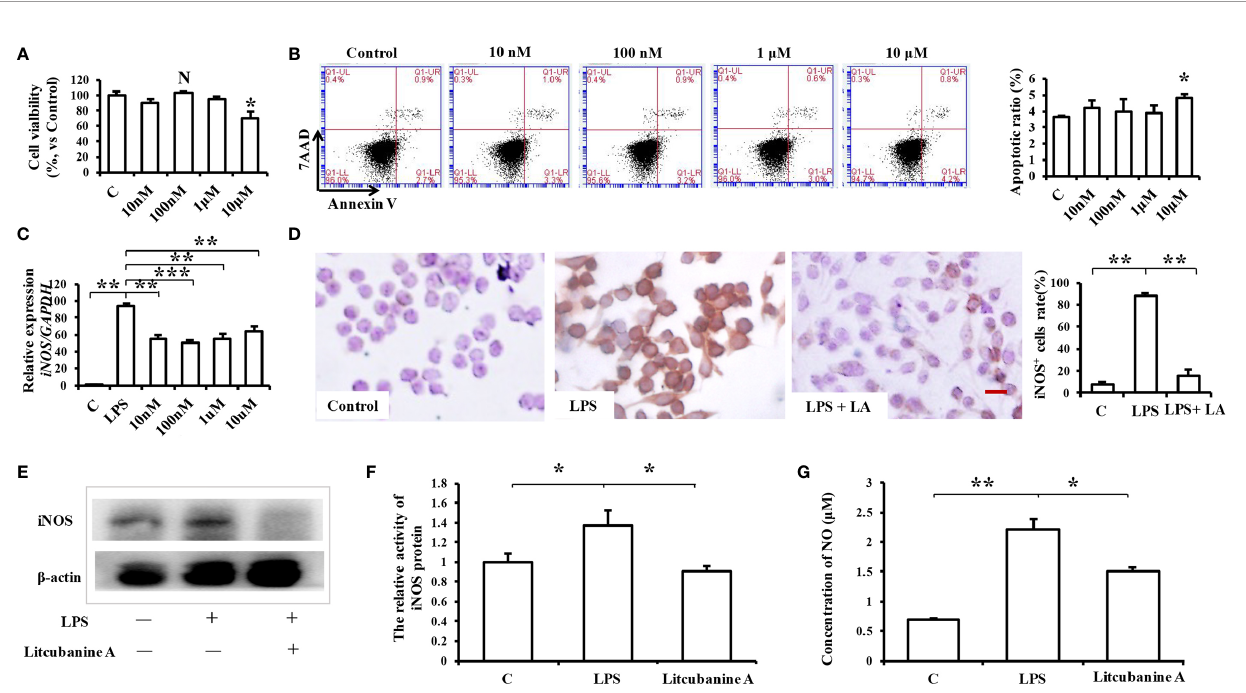
FIGURE 3 | Treatment with 100 nM LA inhibits the LPS-induced expression of iNOS in RAW264.7 macrophages in vitro . (A) CCK8 analysis showing that treatment with 100 nM LA had no effect on cell proliferation (n=3). (B) Flow cytometry analysis showing that treatment with 100 nM LA had no effect on cell apoptosis (n=3). (C) PCR analysis showing that treatment with 100 nM LA signi fi cantly decreased the LPS-induced expression of iNOS in RAW264.7 macrophages. Other concentrations of LA also downregulated the expression levels of iNOS induced by LPS but 100 nM downregulated the expression level of iNOS more stably compared to the other concentrations (n=3). (D) Immunocytochemical staining assays showing that the LPS-induced iNOS-positive cell ratio was signi fi cantly increased after LPS treatment (88.7% ± 1.34%) compared to the control group (7.33% ± 2.50%), and that treatment with 100 nM LA decreased the LPS-induced iNOS positive cell ratio (15.66% ± 5.07%) (n=5). (E) Western blot results con fi rming that treatment with 100 nM LA decreased the protein expression level of total iNOS in RAW264.7 macrophages. (F) Treatment with 100 nM LA inhibited the up-regulation of iNOS protein activity induced by LPS in RAW264.7 macrophages (n=3). (G) Treatment with 100 nM LA decreased the expression level of the downstream product NO induced by LPS in RAW264.7 macrophages (n=3). All results are representative of at least three independent experiments/samples. Results are expressed as means ± standard deviation (SD), and statistical signi fi cance is shown as: N P > 0.05, *P < 0.05, **P < 0.01, ***P <